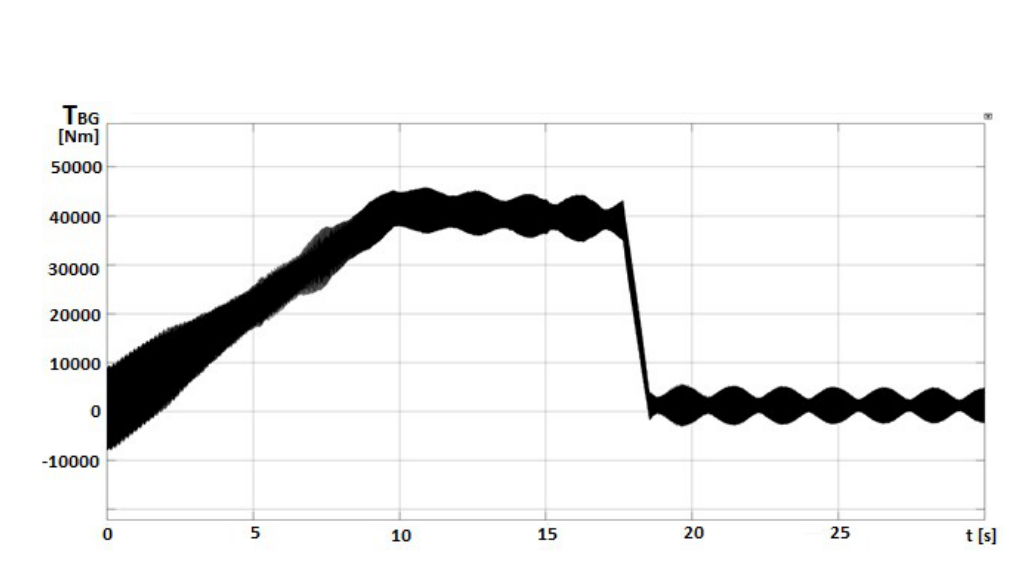
Figure 15. Course of gearwheel accelerating torque.